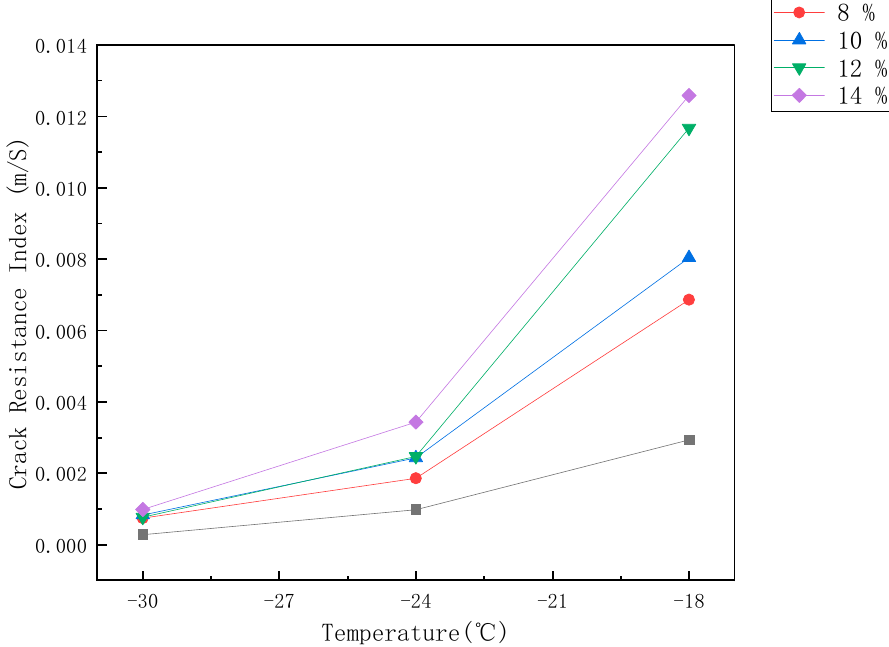
Figure 6. Change curve of m/S value of SBS and SMCSBS with different content with temperature.